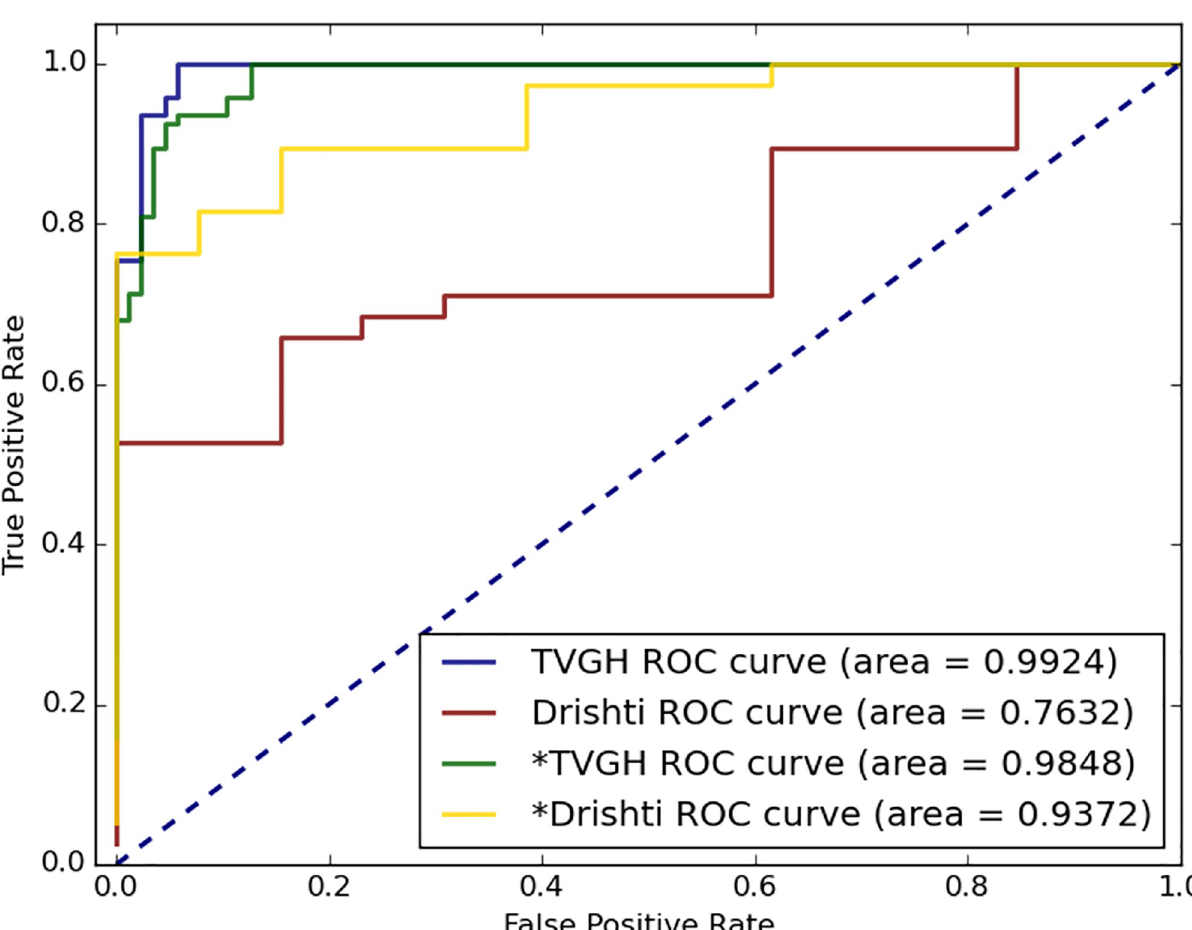
Fig 6. ROC curve of the CNN models to differentiate between the normal disc and glaucomatous disc. The TVGH ROC curve indicated the result through the TVGH-CNN model established based on the TVGH training images to predict the TVGH test images. The Drishti ROC curve indicated the result through the CNN model established using the Drishti-GS training images to predict the Drishti-GS test images. � TVGH and � Drishti used the combined TVGH and Drishti training dataset to predict the TVGH and Drishti test images, respectively. ROC, receiver operating characteristic; CNN: convolutional neural